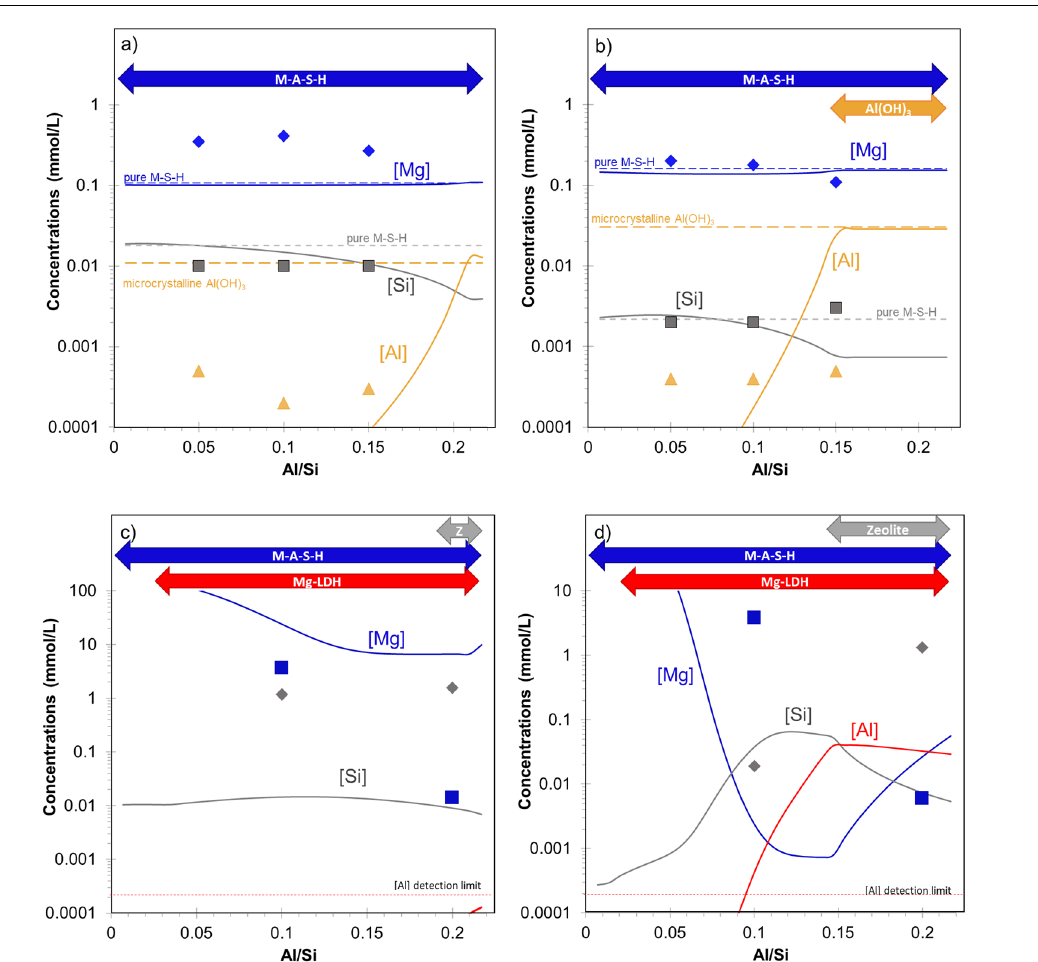
Figure 7. Calculated solubility curves for M ‐ (A ‐ )S ‐ H compared to the available experimental data [46, 50] for a) and c) Mg/Si ~ 1 b) and d) Mg/Si ~ 1.5, c) and d) containing Na 2 CO 3 in the system, using M ‐ A ‐ S ‐ H solid solution [46] and hydrotalcite solid solution [79]. Solubility without the Al incorporation in M ‐ A ‐ S ‐ H, and the formation of Al(OH) 3 are indicated by dotted lines.